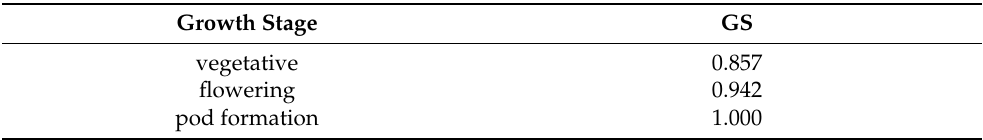
Table 2. GS values for three chickpea growth